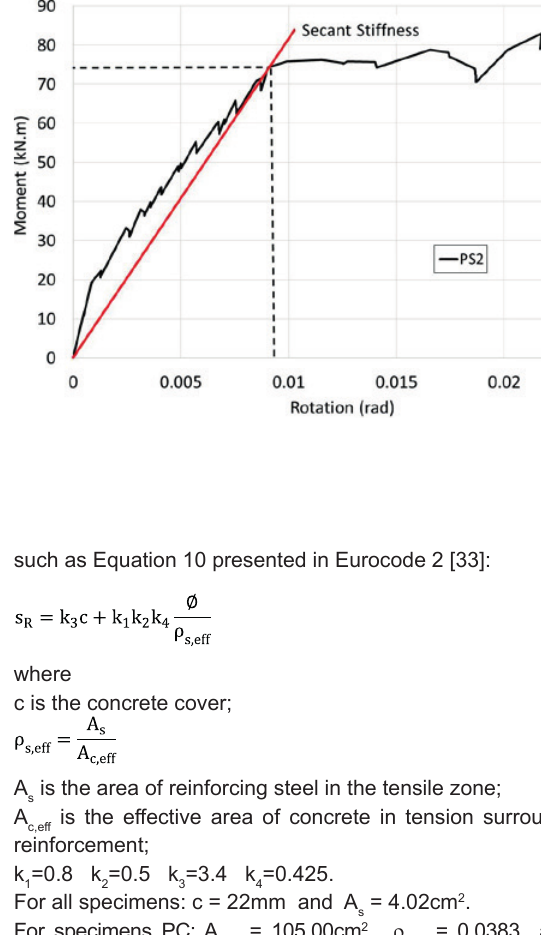
Figure 24 – Moment-rotation curve: specimens PS1 and PS2